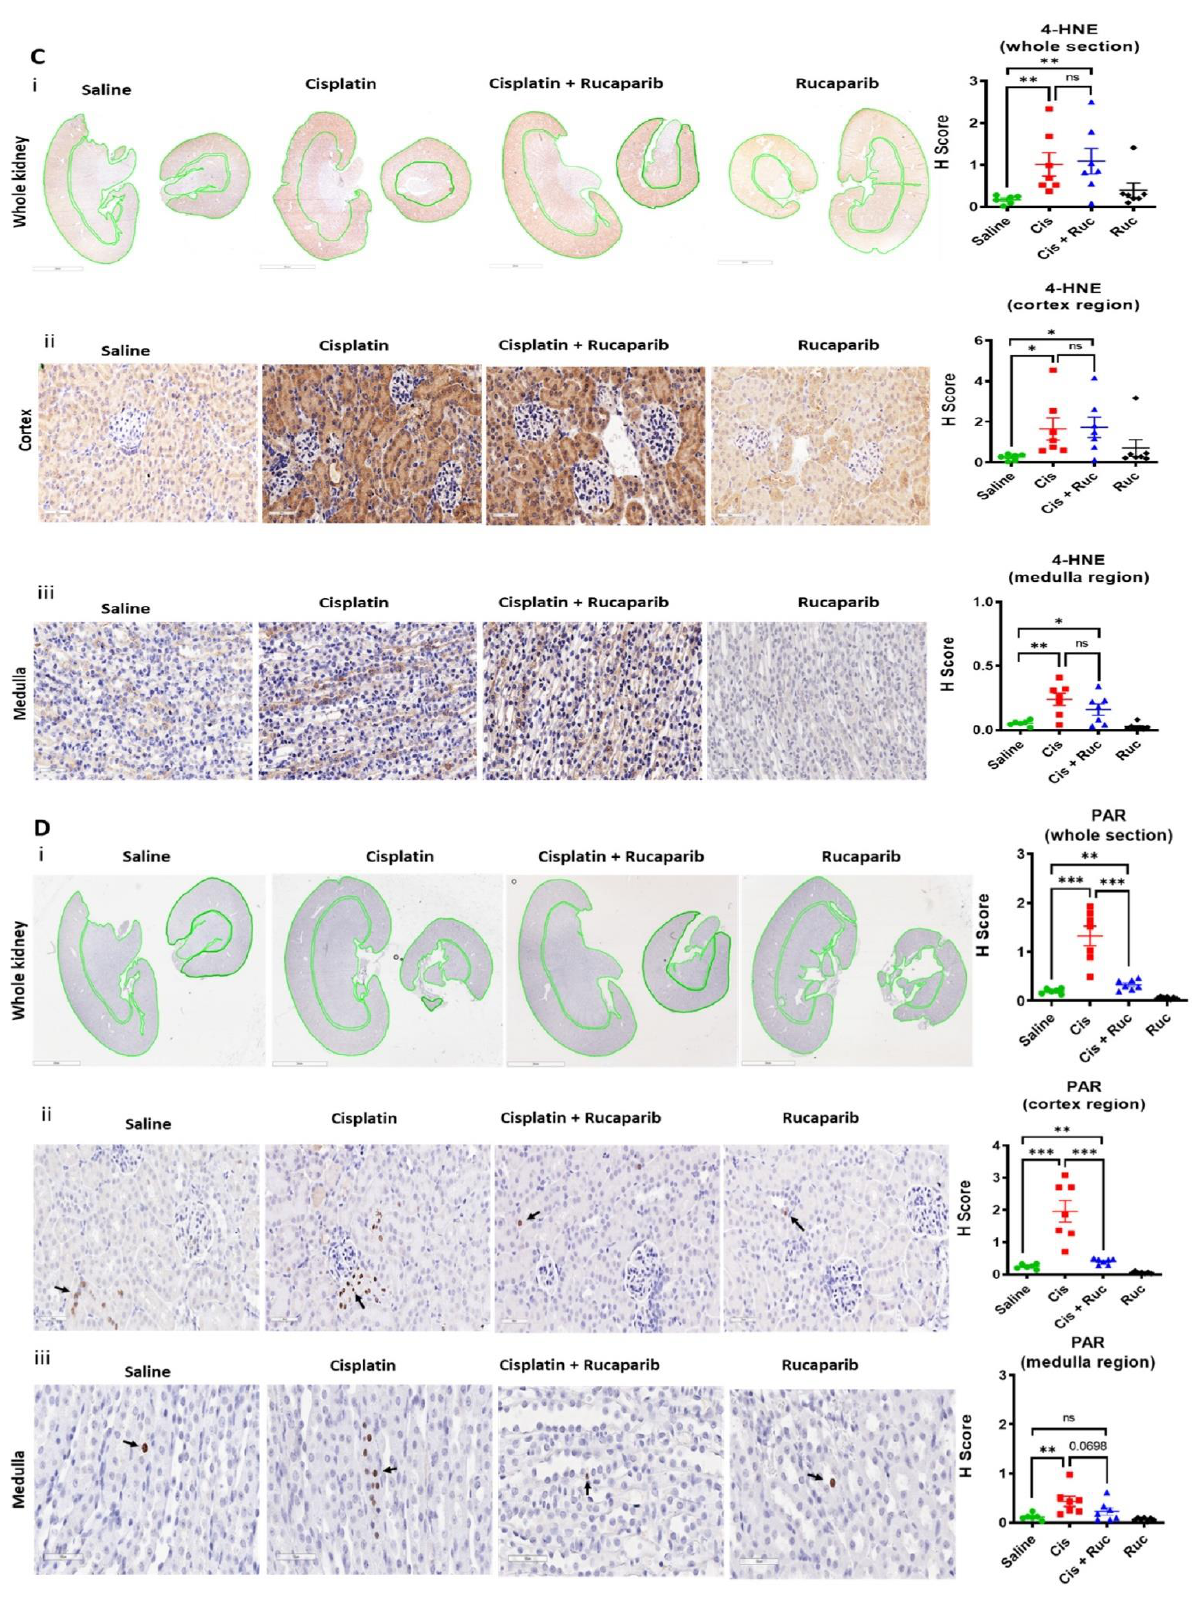
Figure 5. Cisplatin-induced-acute kidney injury is associated with PARP activation and is prevented by rucaparib: Mice were treated with a single dose of 10 mg/kg cisplatin (Cis) on day 1 with or without 5 daily doses of 1 mg/kg rucaparib (Ruc). At the end point (day 5), mice were humanly killed, and blood and kidney tissues were harvested for analysis. ( A ) Blood urea and creatinine levels.